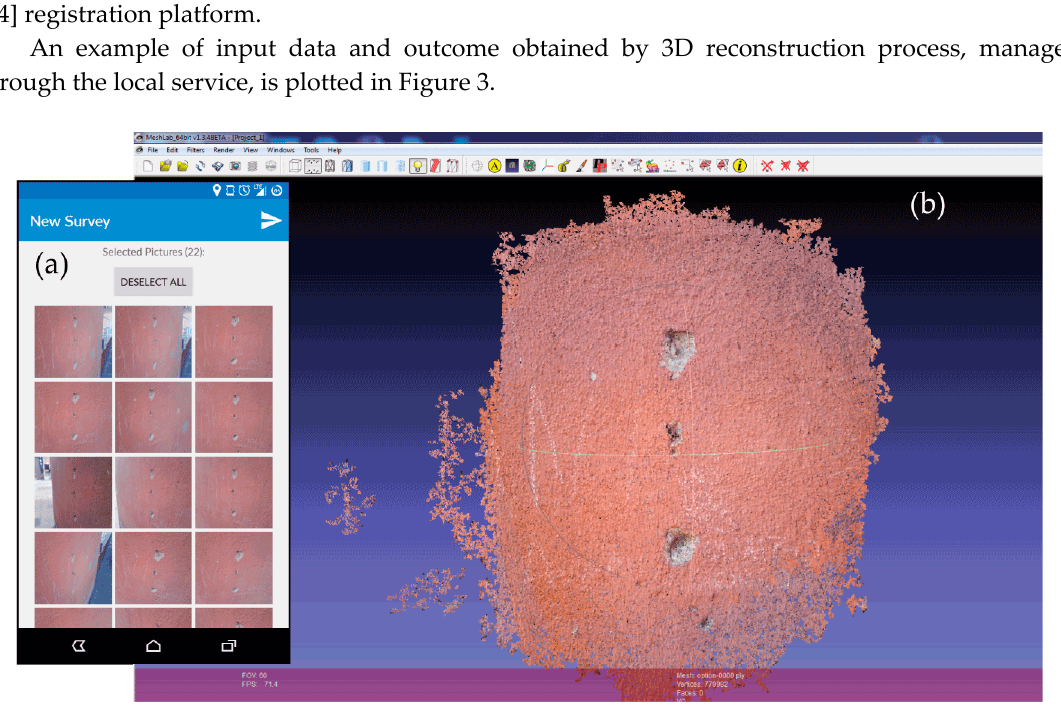
Figure 3. Windows service for managing the 3D reconstruct ion process: input pictures of a plaster detachment acquired by mobile App ( a ) and model visualized through Meshlab software [15] ( b